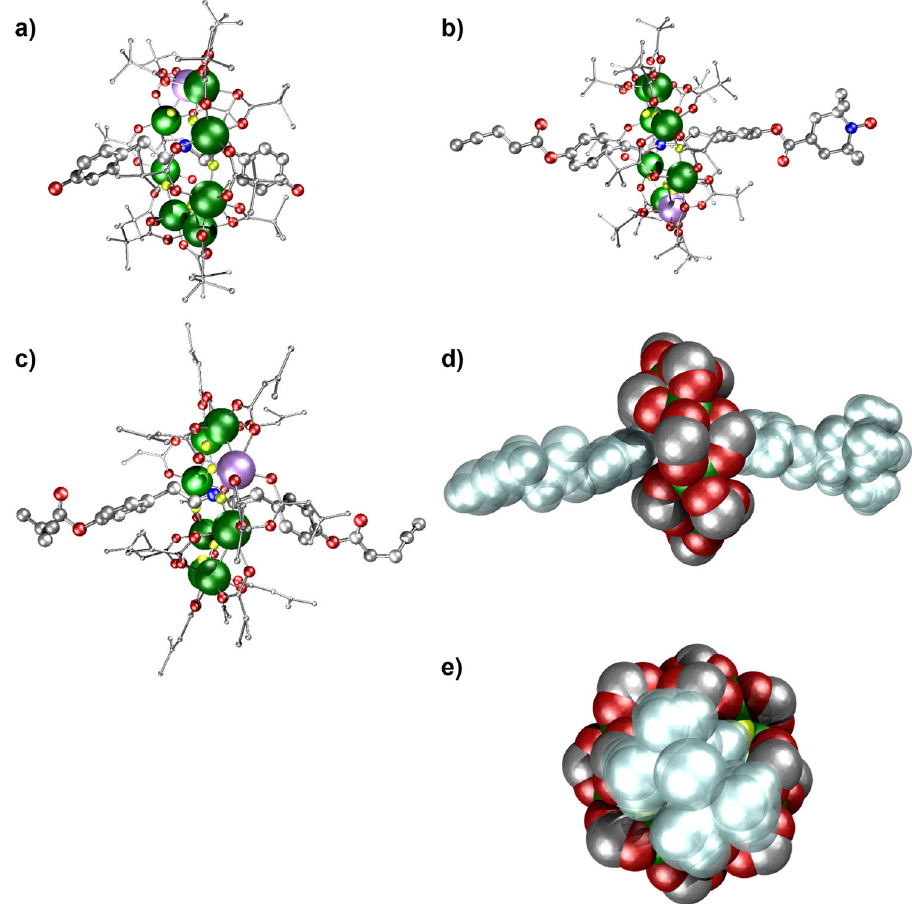
Fig. 2 X-Ray crystal structures of compounds 2, 4 and 10. Ball and stick representations: a 2 ; b 4 ; c 10 . Space- fi lling representations of 4 : d into the edge of the {Cr 7 Ni} ring; e perpendicular to the Cr 7 Ni} ring. Colours in a , b and c : Cr-green, Ni-violet, F-yellow, O-red, N-blue and C-grey. Colours in d and f : thread shown in silver with pivalate groups on rings excluded for clarity. H-atoms excluded for clarity